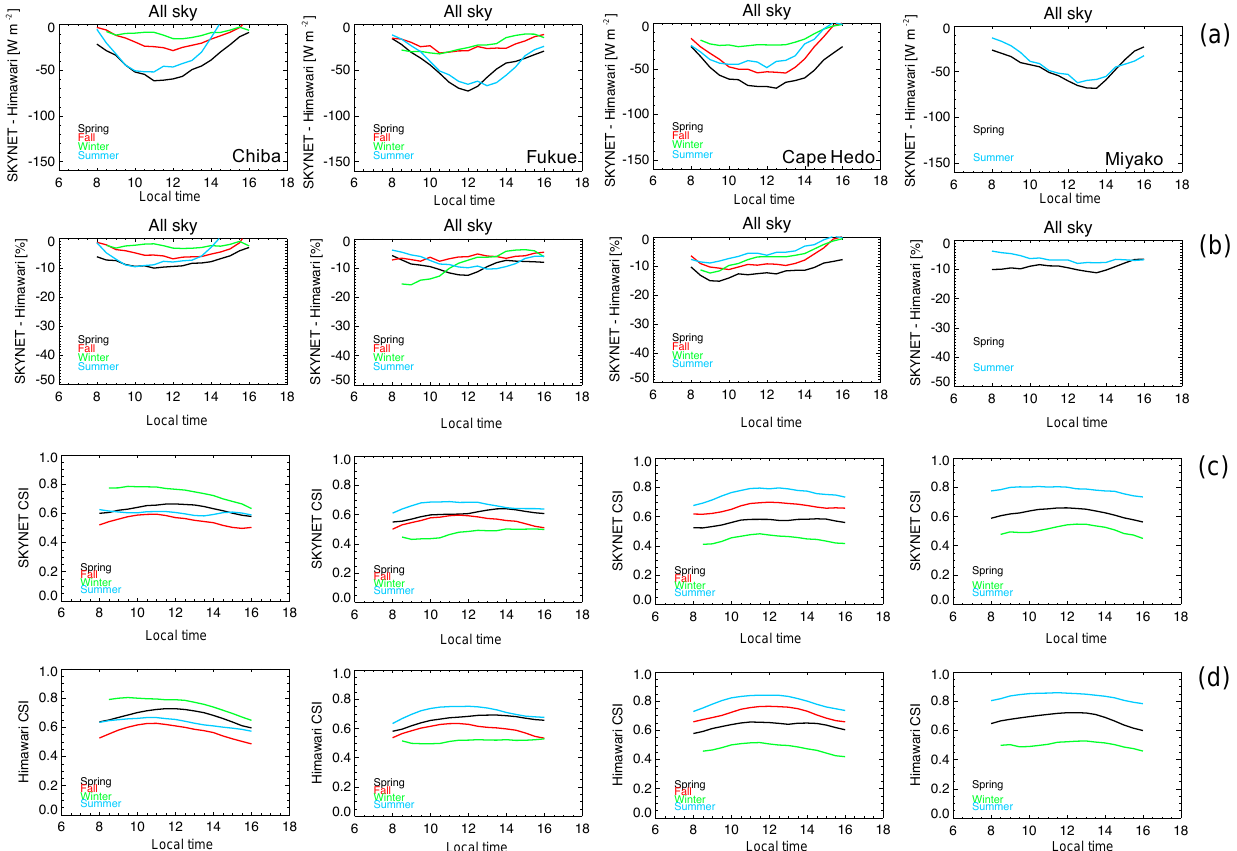
Figure 8. (a, b) Diurnal variation in the difference (i.e., SKYNET data minus Himawari data) in seasonal global radiation for spring, fall, winter, and summer ( a absolute differences, b relative differences). (c, d) Diurnal variation in seasonal CSI for spring, fall, winter, and summer ( c : SKYNET-based CSI, d Himawari-based CSI). A running average of 1h is applied to the instantaneous data. Results are shown for (left to right) Chiba, Fukue, Cape Hedo, and